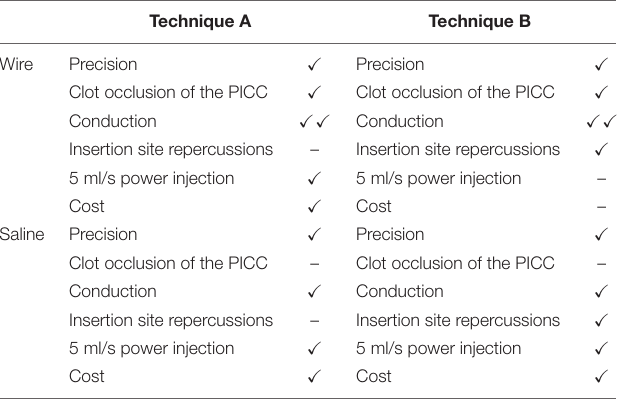
TABLE 1 | Summary of the different advantages and limits of PICC devices classified by technique and transmission medium. Technique A Technique B